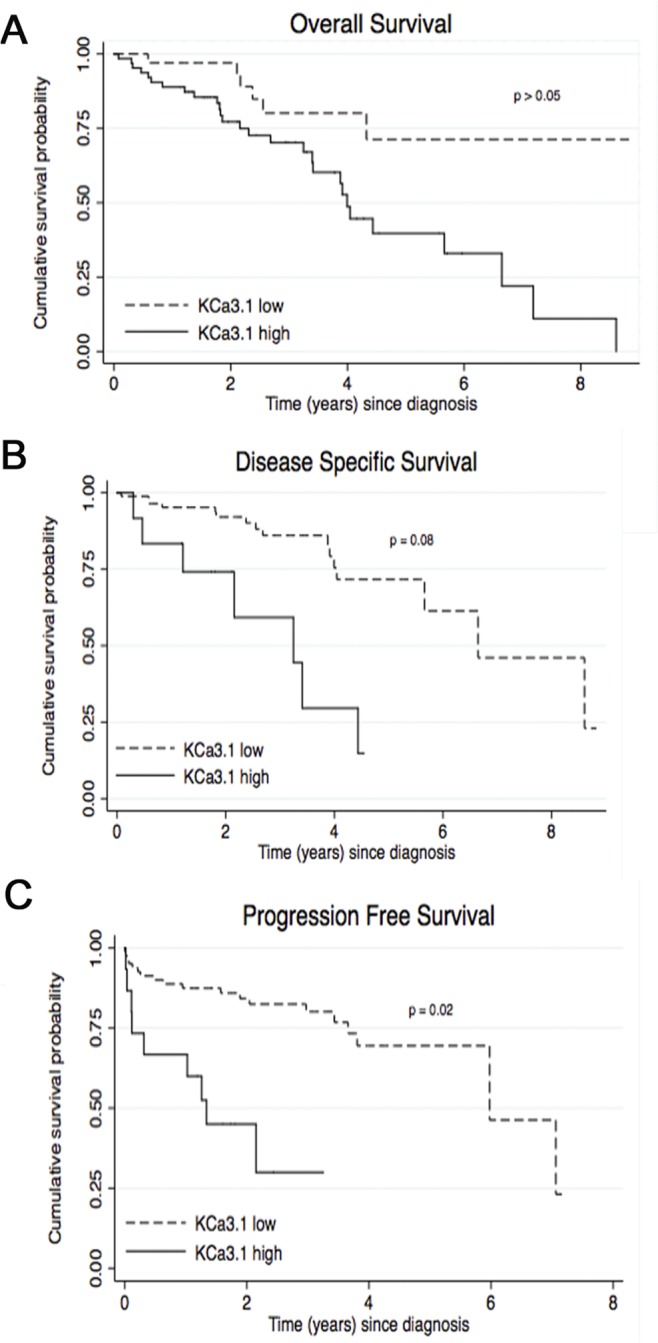
KCa3.1-mRNA expression levels are a significant prognostic indicator of Progression Free Survival in ccRCC.A-C: Kaplan Meier survival analysis indicates that patients with high KCa3.1-mRNA expression have a significantly shorter Progression Free Survival (p = 0.02). Moreover, we found a trend towards a significantly shorter Disease Specific Survival for patients with a high KCa3.1 mRNA expression (p = 0.08).